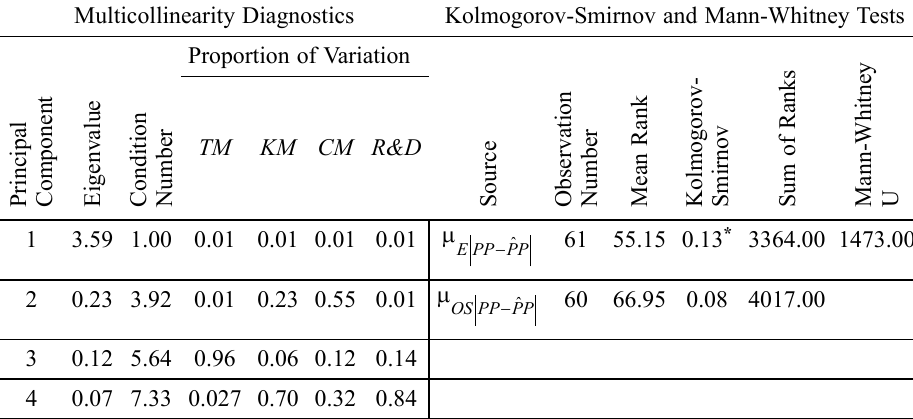
Table 3. Multicollinearity diagnostics, Kolmogorov-Smirnov, and Mann-Whitney tests of Model 4 a Multicollinearity